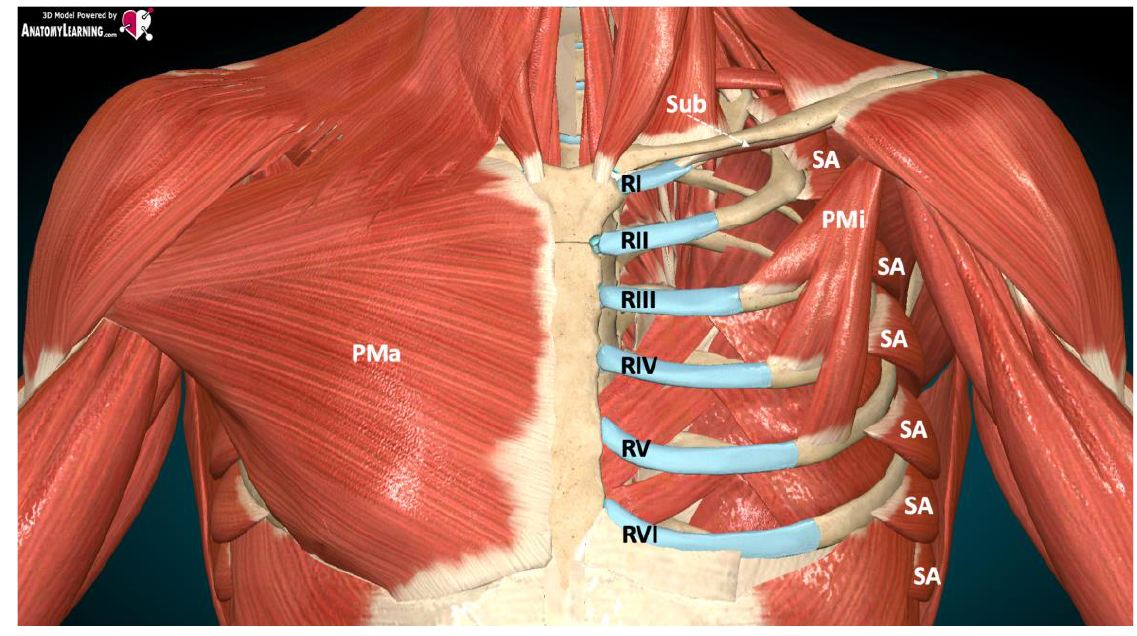
Figure 3. Muscle anatomy during the performance of PECS blocks [6]. Legend: RI, first rib; RII, second rib; RIII, third rib; RIV, fourth rib; RV, fifth rib; RVI, sixth rib; PMa, pectoralis major muscle; PMi, pectoralis minor muscle; SA, serratus anterior muscle; Sub, subclavian muscle.